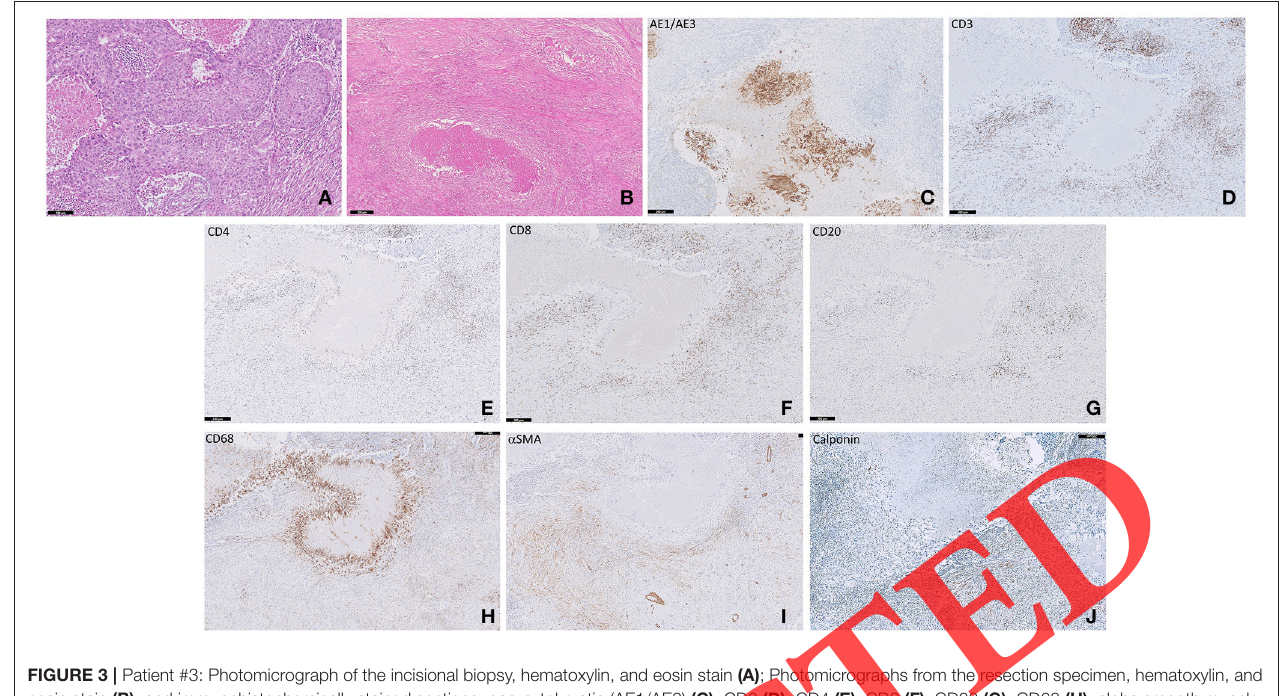
FIGURE 3 | Patient #3: Photomicrograph of the incisional biopsy, hematoxylin, and eosin stain (A) ; Photomicrographs from the resection specimen, hematoxylin, and eosin stain (B) , and immunohistochemically stained sections: pan-cytokeratin (AE1/AE3) (C) , CD3 (D) , CD4 (E) , CD8 (F) , CD20 (G) , CD68 (H) , alpha smooth muscle actin ( α SMA) (I) , calponin (J) ( A : scale bar 100 µ m and B–J : scale bar 200 µ